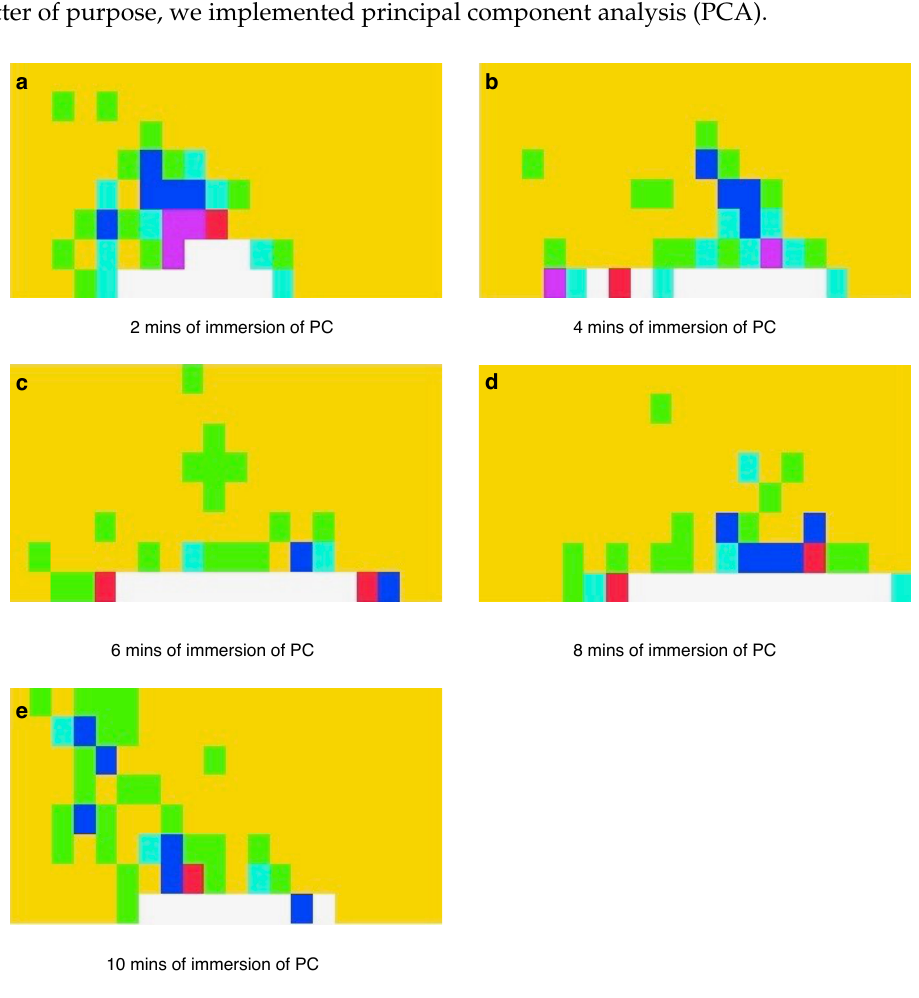
Figure 7. Visualization of bin matrices corresponding to different immersion times (i.e. ( a ) 2 min, ( b ) 4 min ( c ) 6 min ( d ) 8 min ( e ) 10 min) for the crystallized PC. The horizontal axis indicates the height where the feature started to appear and the vertical axis indicates the height of the structure. Bins’ dimensions are 0.5 µ m × 0.5 µ m Yellow squares shows empty bins. Green, cyan, blue, purple and red bins contain 1, 2, 3, 4 and 5 features, respectively. White bins concentrated at the bottom contains more than five nanoscale and subnanoscale